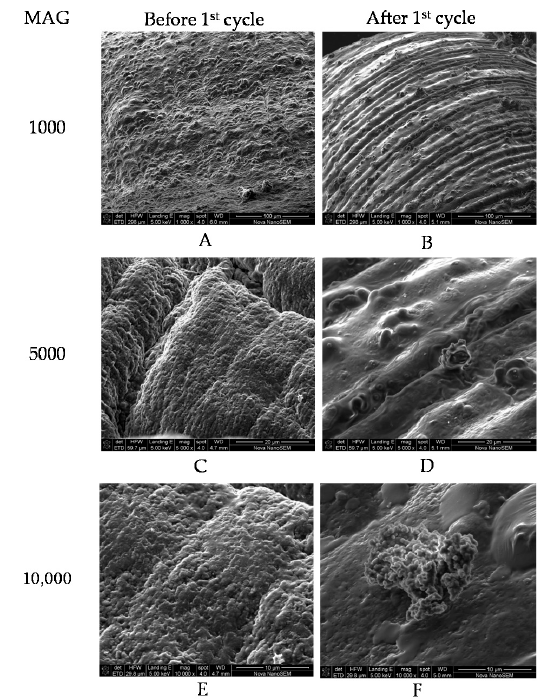
Figure 3. Scanning electron micrographs (SEM) of Ca-alginate beads before and after first cycle fermentations at 1000× ( A , B ), 5000× ( C , D ) and 10,000× ( E , F ) magnifications.